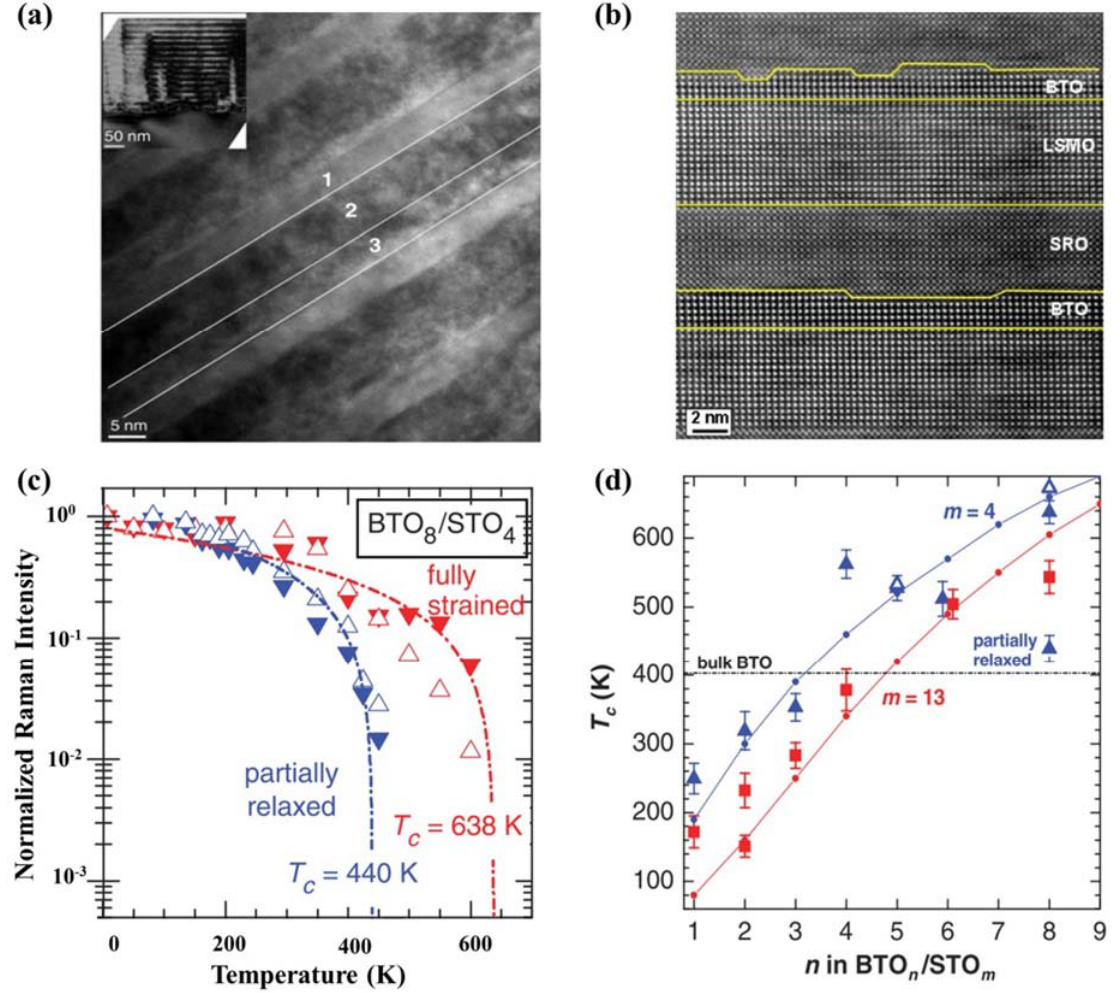
Figure 5. ( a ) Cross section high resolusion transmission electron microscopy (HRTEM) micrographs of BTO, LSMO and SRO layers (marked by “1”, “2” and “3”) [146]; ( b ) cross section high angle annular dark field scanning transmission electron microscopy (HAADF-STEM) micrographs of LSMO–SRO superlattices with BTO interlayers (the lines indicate the interfaces) [146]; ( c ) temperature dependencies of normalized Raman intensities of TO 2 (solid triangles) and TO 4 (open triangles) phonons for (BTO 8 /STO 4 ) × 10 and (BTO 8 /STO 4 ) × 40 (partially relaxed), with the dash-dotted lines being fit to a linear temperature dependence [147]; ( d ) dependence of T c on n and m in superlattices BTO n /STO m (n and m refer to the thickness in unit cells). Blue symbols are for m = 4 and red symbols are for m = 13. Open triangles are from temperature-dependent XRD measurements. Circles with lines are from the 3D phase-field model calculations. The black horizontal dash-dotted line shows the T c in bulk BaTiO 3